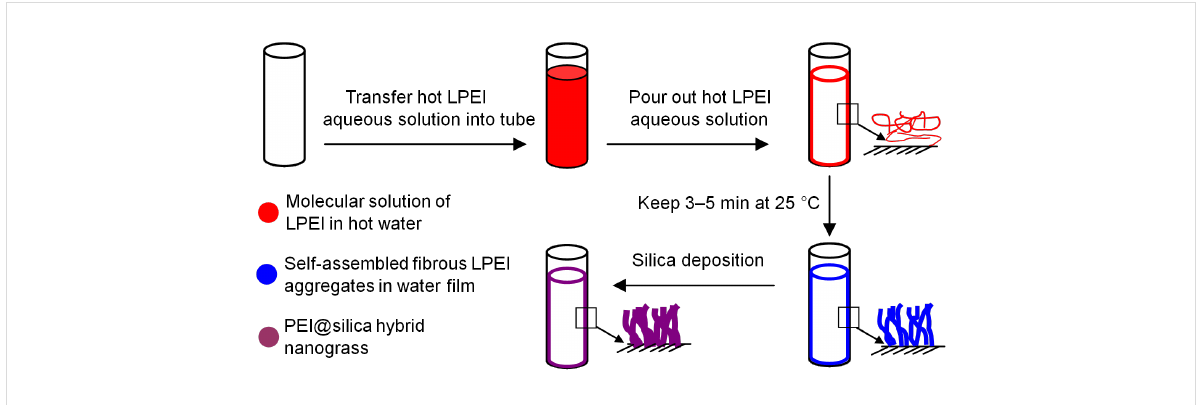
Figure 1: Schematic demonstration of the bio-inspired generation of LPEI@silica hybrid nanograss surface on the inner wall of a glass tube by miner- alization of silica on the nanostructured matrix from self-assembled LPEI aggregates.